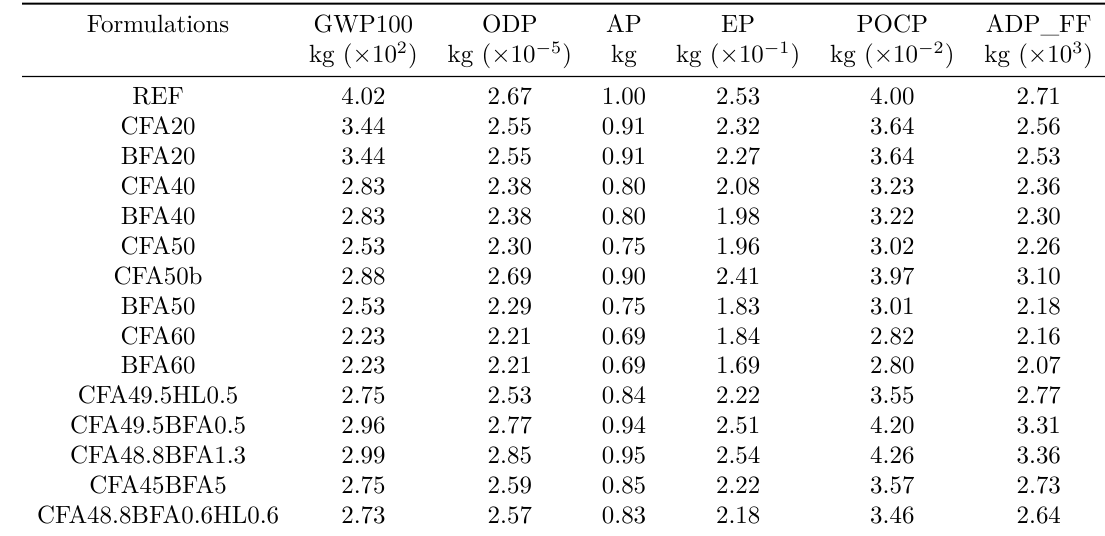
Table 4. Values obtained for the di ff erent environmental impacts.